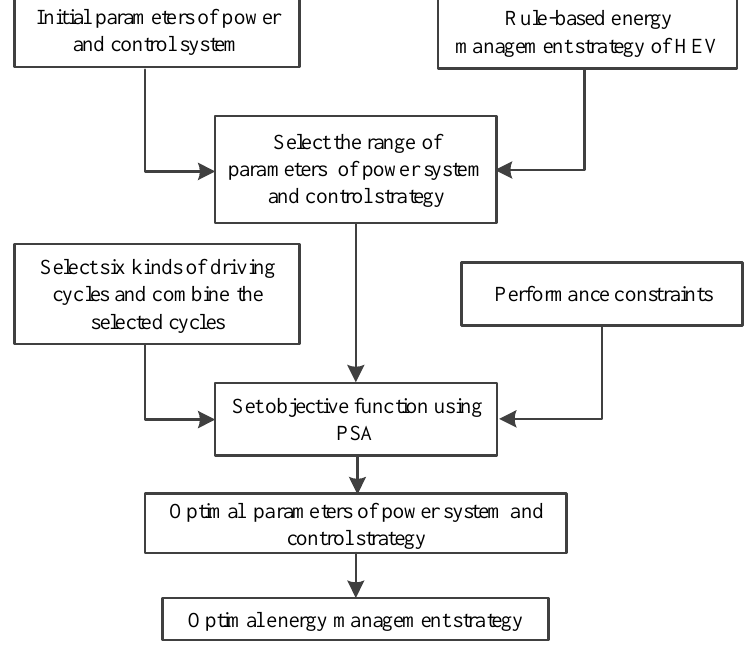
Figure 3. Diagram of optimization method under multiple driving cycles.